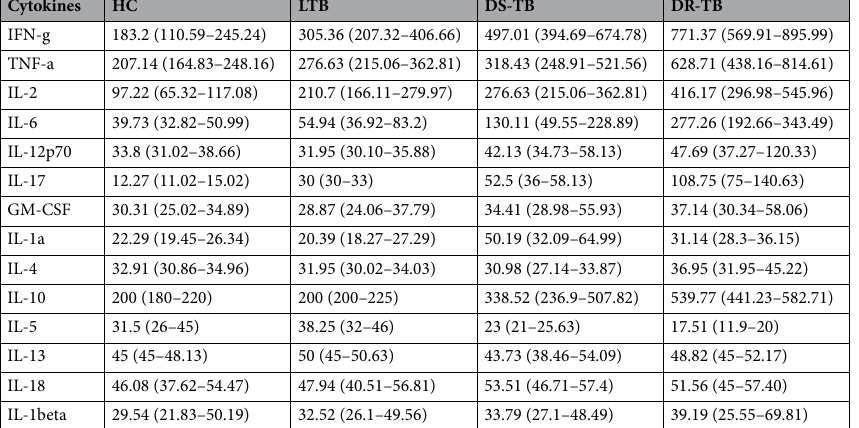
Table 2. Cytokine concentration shown as median and interquartile range (Q1 and Q3) across the